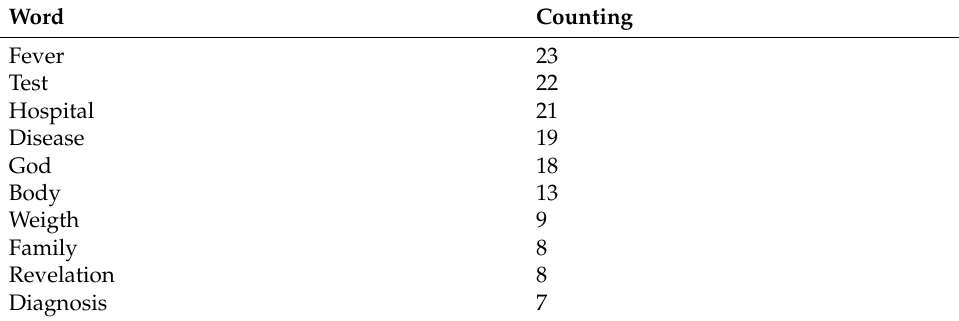
Table 1. Frequency of the 10 most quoted words in the